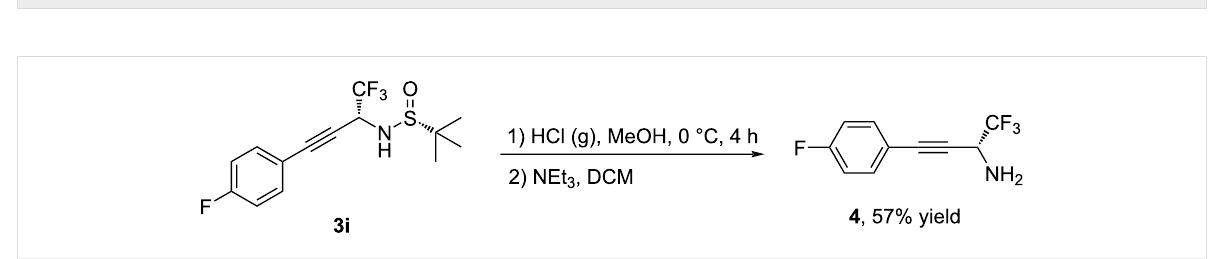
Scheme 3: Large-scale application of the reaction.